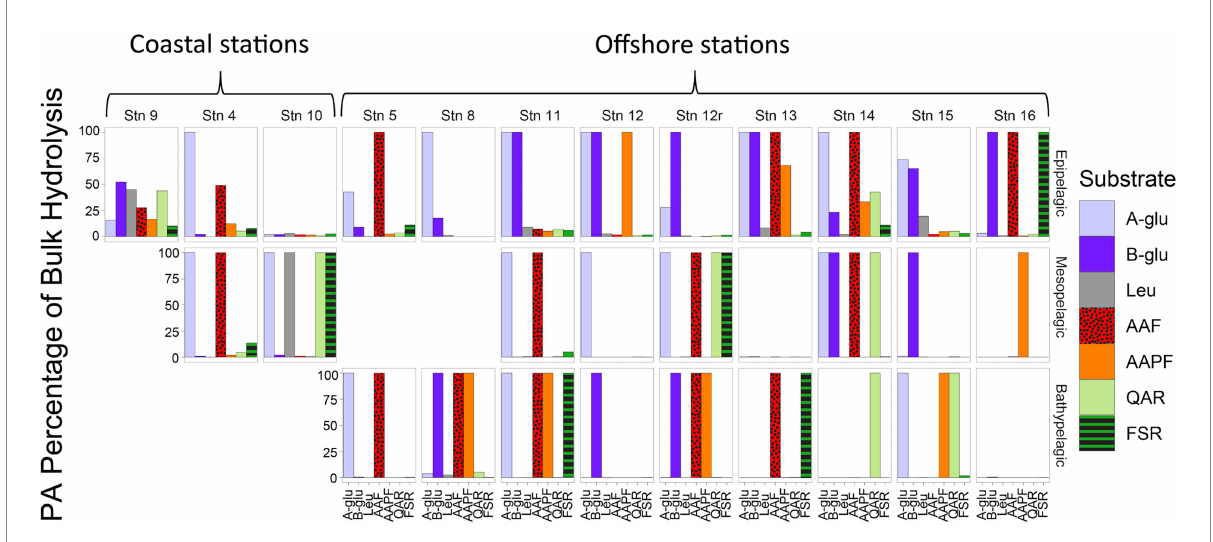
FIGURE 2 Percent of bulk water glucosidase and peptidase activities that is attributable to the PA fraction, calculated by comparing the maximum rate of the bulk water and PA samples. A-glu, alpha-glucosidase; B-glu, beta-glucosidase; Leu, leucine aminopeptidase; AAF, alanine–alanine-phenylalanine- chymotrypsin; AAPF, alanine–alanine-proline-phenylalanine-chymotrypsin; QAR, glutamine-alanine-arginine-trypsin; FSR, phenylalanine-serine-